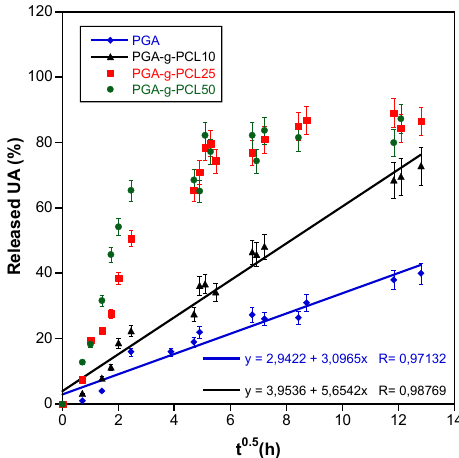
Figure 5. Higushi plot: released UA (%) vs. the root square of time.